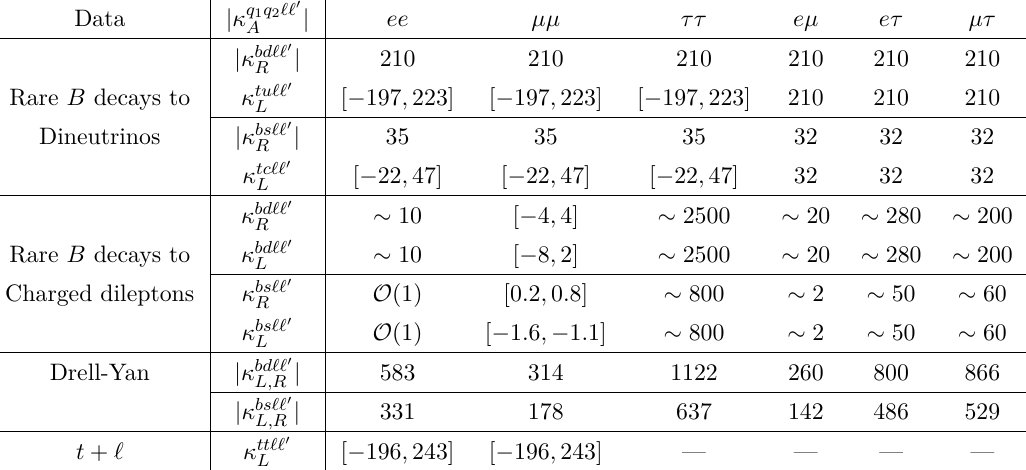
Table 3 . Upper limits on bd, bs, tu, tc charged lepton couplings κ q 1 q 2 ‘‘ 0